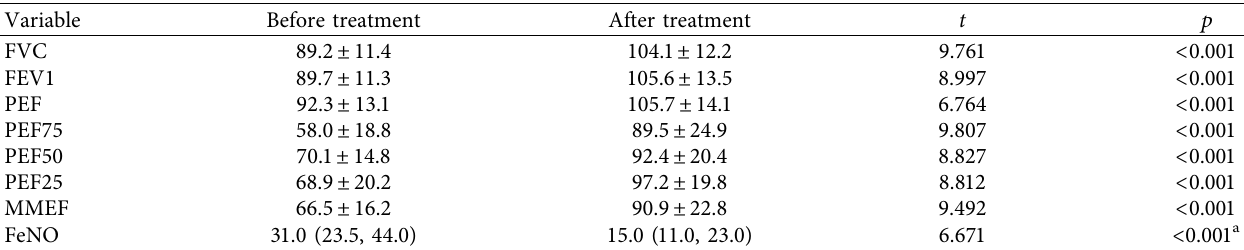
Table 7: Comparison of pulmonary function and FeNO in the multiple allergic group before and after treatment.